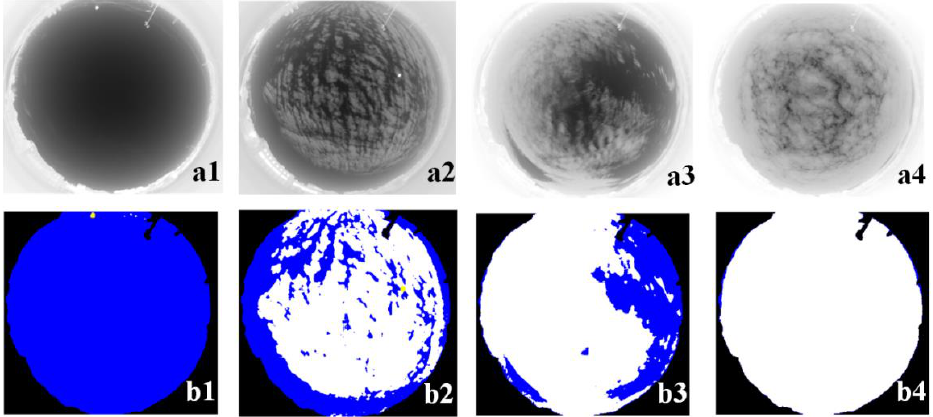
Figure 7. ( a1 – a4 ) are the original infrared sky images, and ( b1 – b4 ) show the segmentation results of clouds detection, Figure 7. Figures 7 ( a1 – a4 ) are the original infrared sky images, and Figures 7( b1 – b4 ) show the segmentation results of clouds detection, indicating the clouds (in white) and clear sky (in blue). indicating the clouds (in white) and clear sky (in